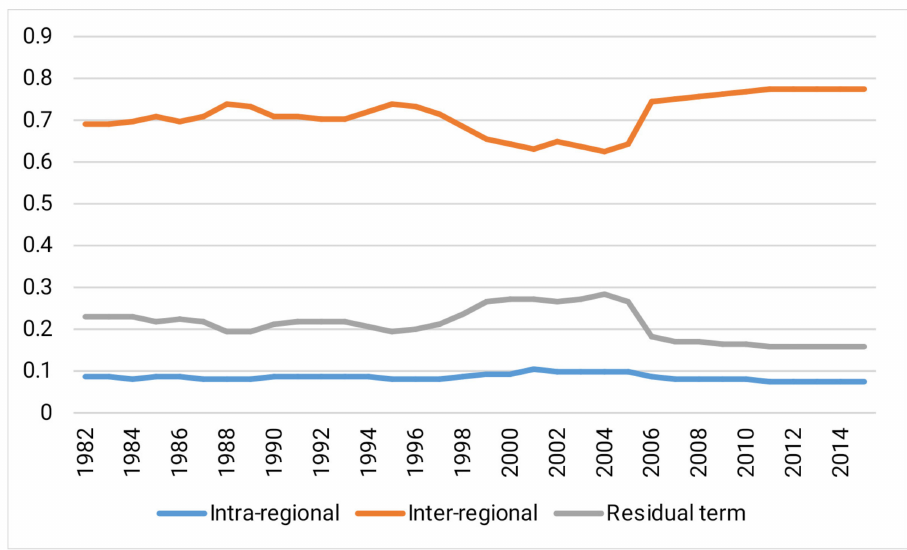
Figure 6. Composition of China’s TI inequality.